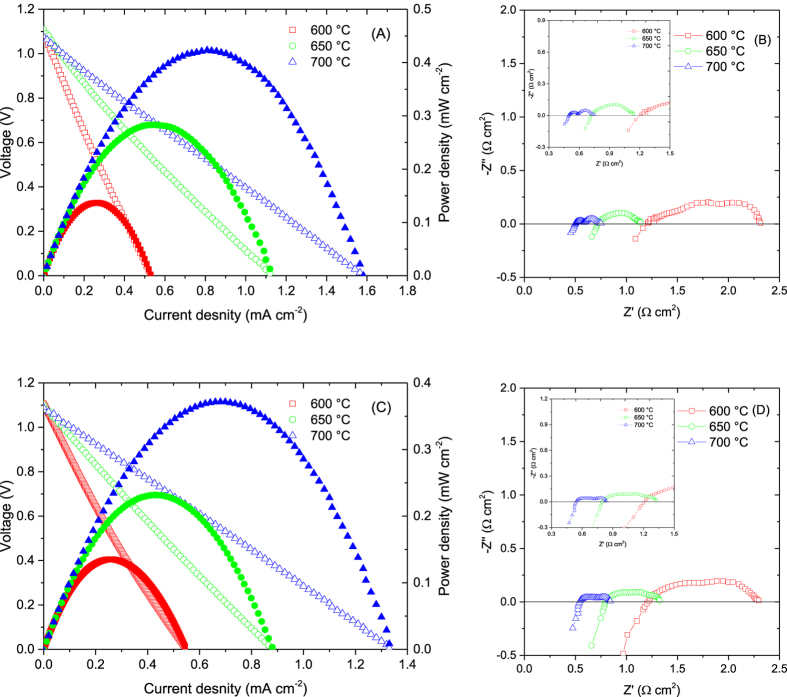
Fuel cell performance.Current-voltage curves (A,C) and impedance spectra (B,D) of solid oxide fuel cells with SrFe0.8Cu0.1Nb0.1O3−δ (A,B) and SrFe0.9Nb0.1O3−δ (C,D) anode.